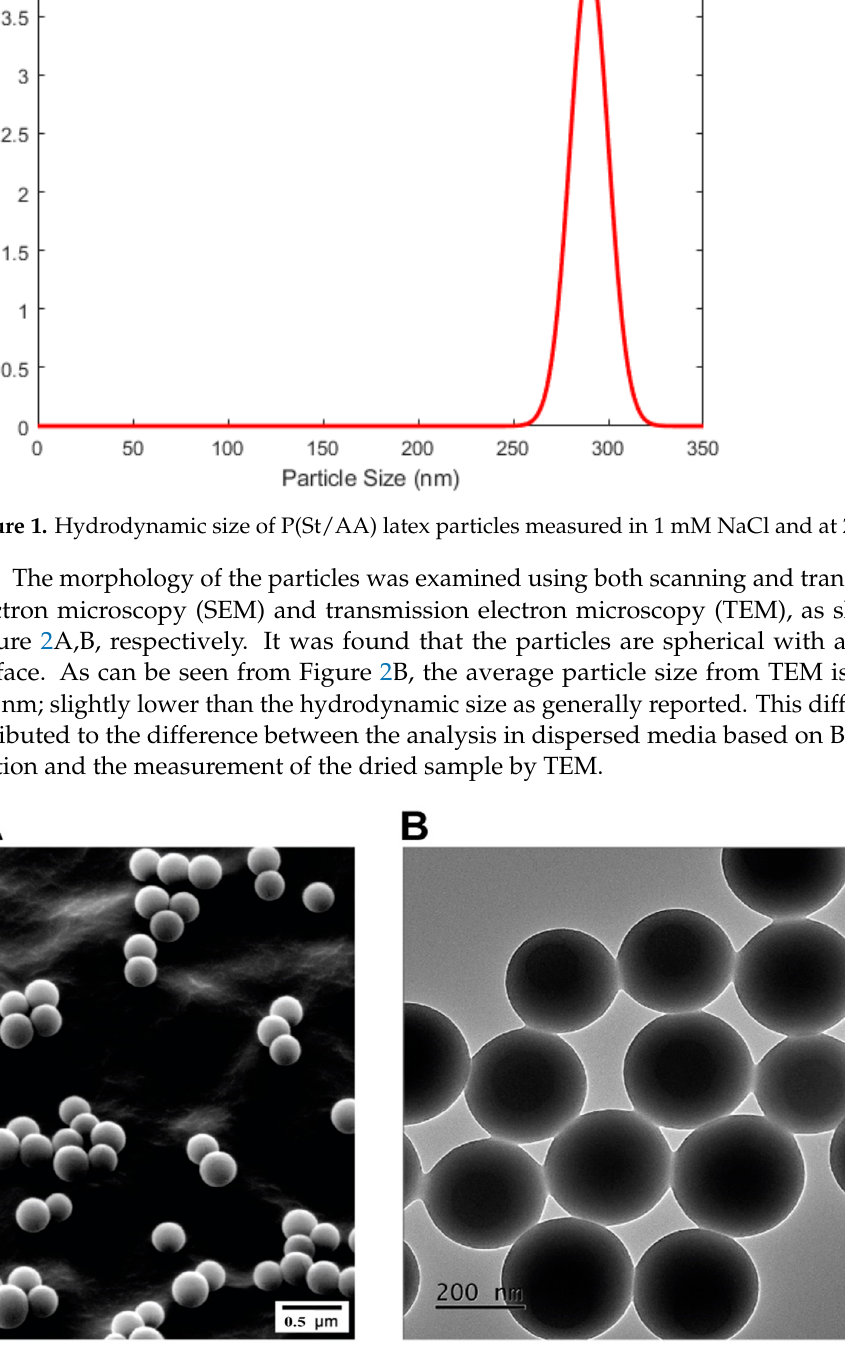
Figure 2. ( A ) Scanning electron microscopy image of P(St/AA) particles. ( B ) Transmission electron microscopy images of P(St/AA) particles. The zeta potential of P(St/AA) latex particles was determined by measuring the elec- trophoretic mobility as a function of pH at 20 °C. The measured electrophoretic mobilities